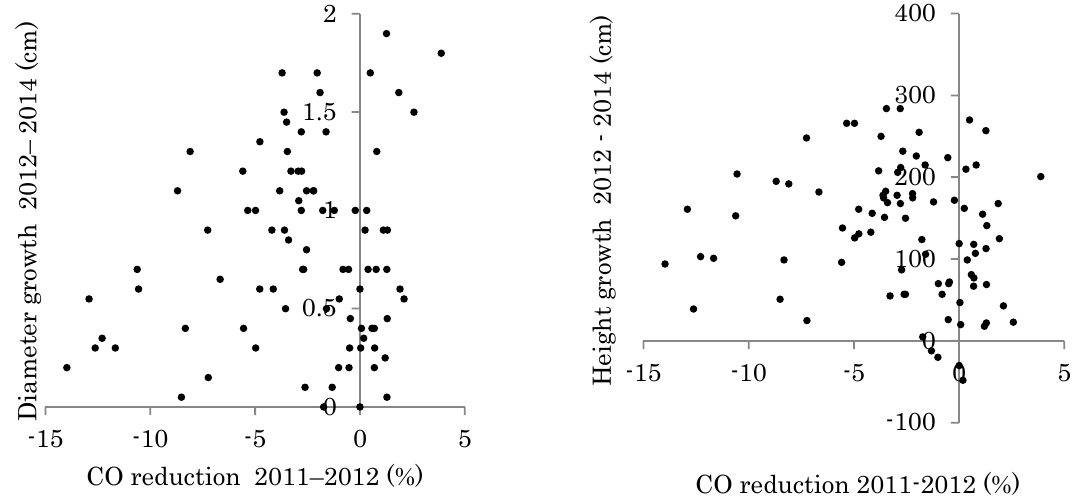
Figure 9. Correlation between the CO reduction from 2011 to 2012 at each photo point in the planting line ( n = 63) and seedling growth from 2012 to 2014.